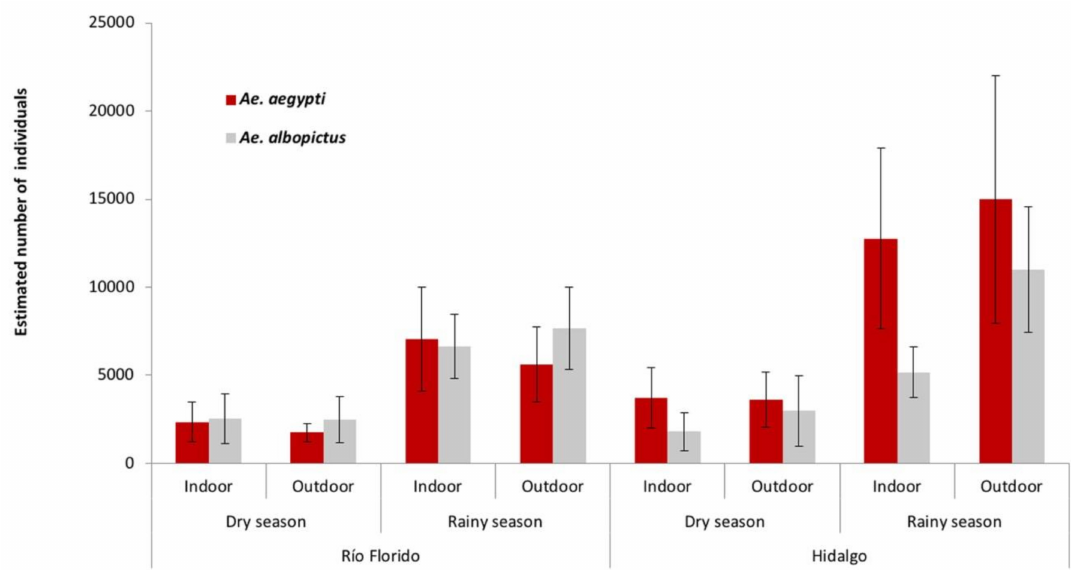
Figure 2. Mean (+SE) estimated abundance of Aedes aegypti and Ae. albopictus based on egg counts from indoor and outdoor ovitraps in the dry and rainy seasons during a three-year study in R í o Florido and Hidalgo villages. Abundance was calculated as the product of number of eggs per location of ovitrap in village by season and the proportion of each species present in laboratory-reared